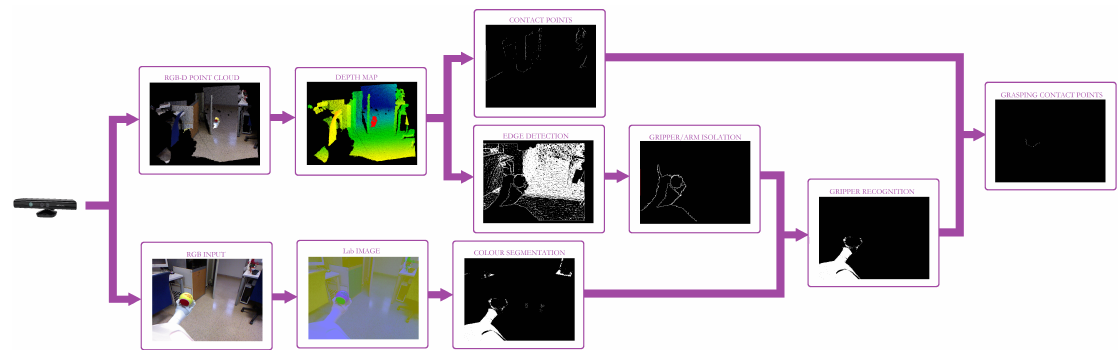
Figure 8. Our approach flowchart for robust grasping